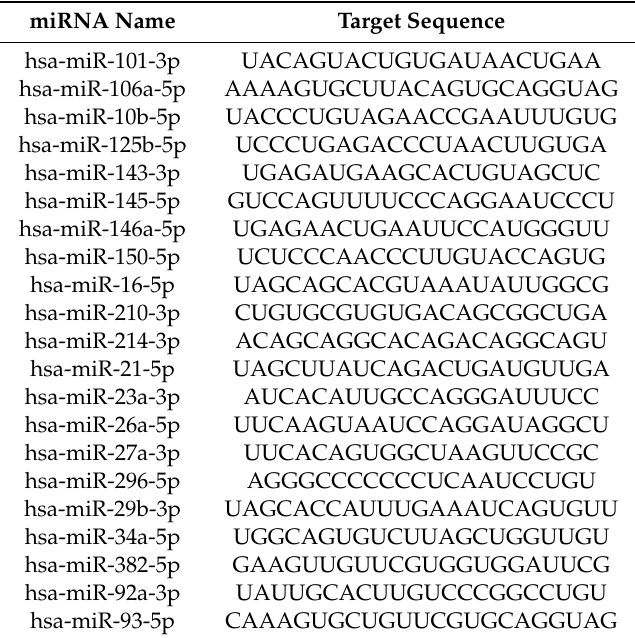
Table 2. miRNA name and target sequences.